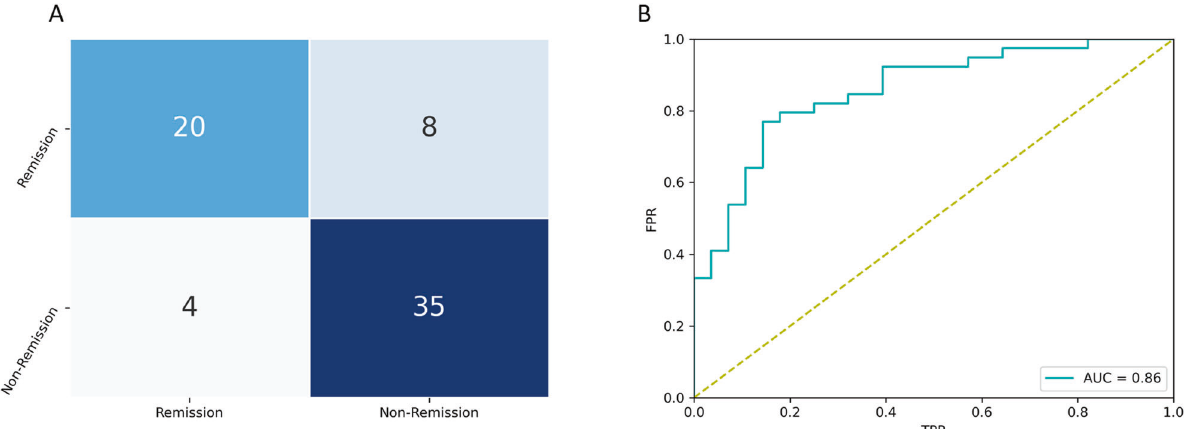
Fig. 2 The performance of the prediction model. A The confusion matrix of the prediction model. The horizontal ordinate is the predicted value, and the longitudinal ordinate is the actual value. 20 remission group members were correctly predicted as remission, and 35 non- remission group members were correctly predicted as non-remission. B The ROC of the prediction model. The AUC is 0.86, accuracy is 82.08% sensitivity is 71.43%, and speci fi city is